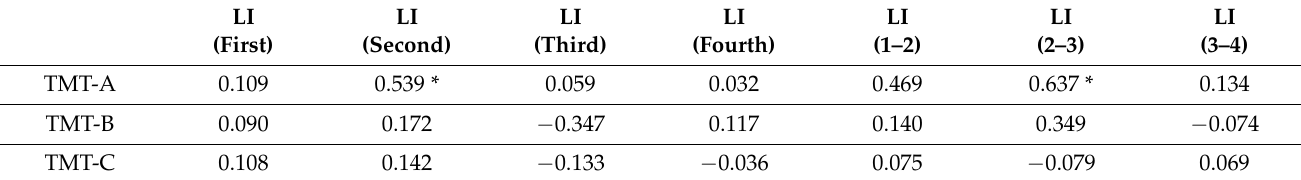
Table 4. Correlation between LI and LI variability and salivary amylase